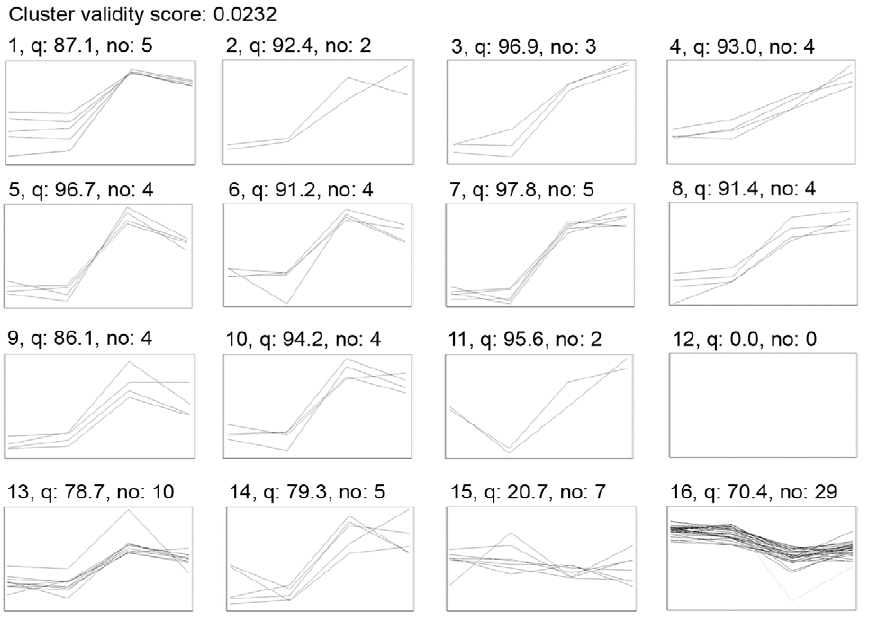
Figure 3. SOM analysis. A SOM analysis was performed to group spots with a similar expression pattern, in this way clustering the spots that are regulated in the same way. Sixteen clusters were obtained, one (12) containing no spots. The X-axis chronologically displays the experimental groups (C-O-T-R) while the Y-axis displays the log standardized abundance (scale is not identical for the different clusters). The cluster number, quality value (q) and number of spots present in the cluster (no) are indicated above the graphs.